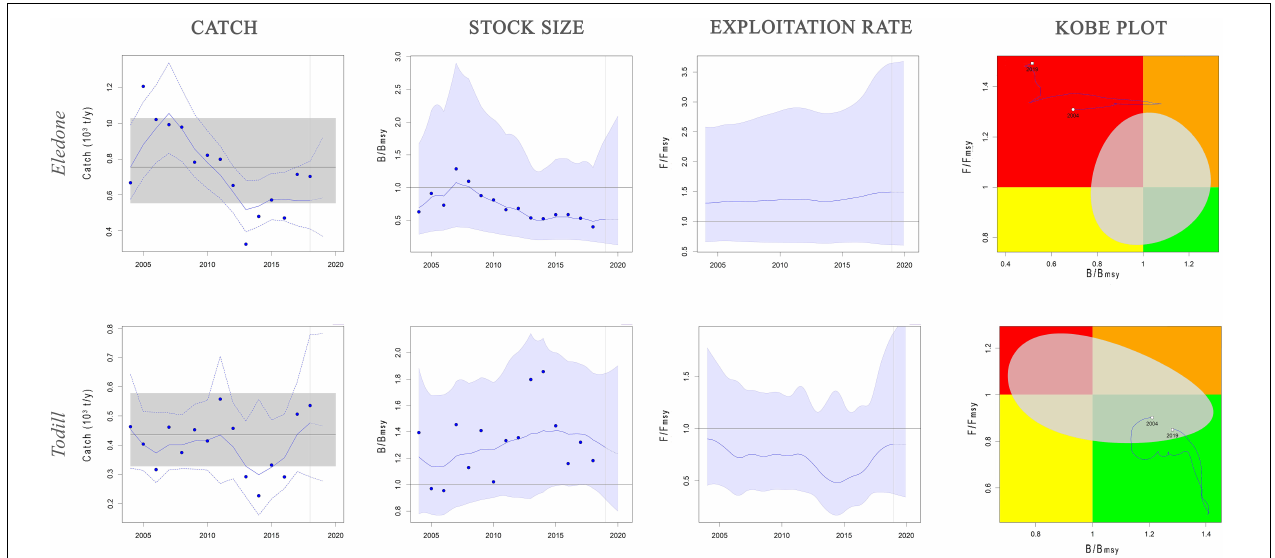
FIGURE 4 | Dynamics of Eledone and Todill stocks estimated by SPiCT model. Catch panel: blue solid line shows the estimated catches, blue dashed lines the 95% confidence interval of the estimated catches, black solid line the mean value of MSY and gray shaded area the 95% confidence interval of MSY. Stock size and exploitation rate panels: trend of B/B MSY and F/F MSY , with the light blue area showing the 95% confidence interval. Kobe plot panel: B/B MSY against F/F MSY ratios for the years with available data (2004–2018). Quadrants are color-coded, i.e., red area: stocks that are both overfished (low relative biomass) and in overfishing (high exploitation rate) (B ≤ B MSY ; F ≥ F MSY ); orange area: relative biomass is quite high but exploitation rate is high (B ≥ B MSY ; F ≥ F MSY ); yellow area: recovering stocks (B ≤ B MSY , F ≤ F MSY ); green area: stocks subject to sustainable exploitation rate and with healthy stock biomass that can produce high yields close to MSY (B ≥ B MSY , F ≤ F MSY ). Gray area represents the uncertainty, expressed as 95% confidence interval, of the reference